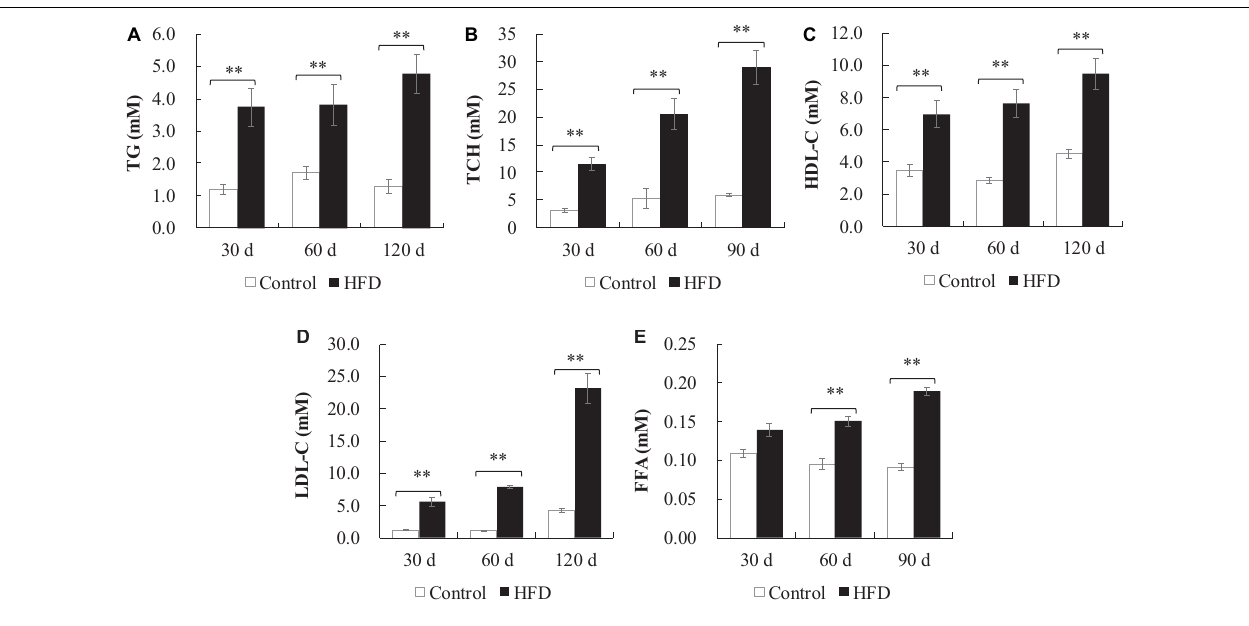
FIGURE 2 | Plasma lipid parameters of tilapia fed on control diet and HFD for 90 days. (A) TG content; (B) TCH content; (C) HDL-C content; (D) LDL-C content; (E) FFA content. All values are expressed as mean ± SEM ( n = 10); ∗∗ P < 0.01 versus control at same time.